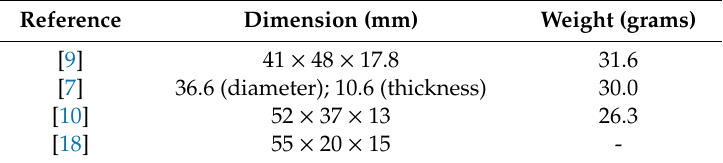
Table 3. Dimension and weight of the devices cited in the state of art.